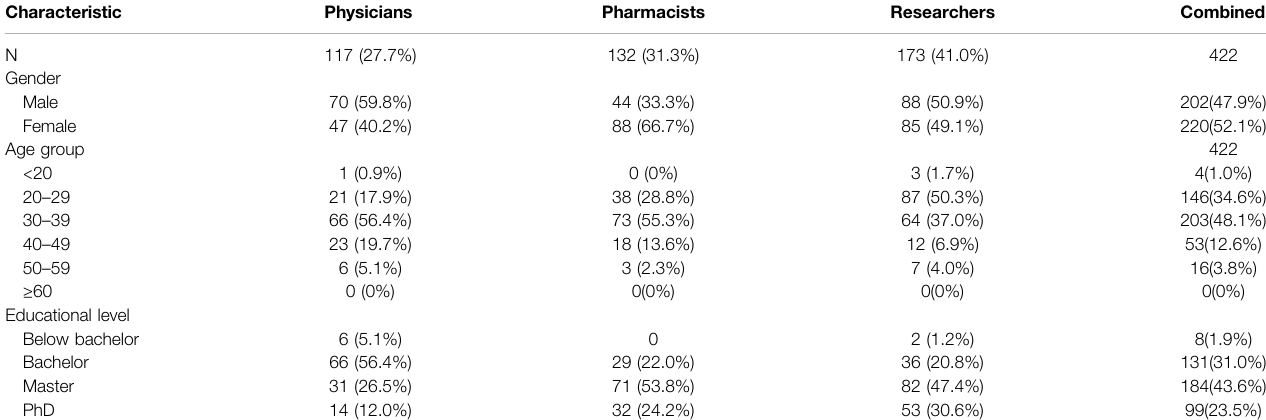
TABLE 1 | Characteristics of responders.